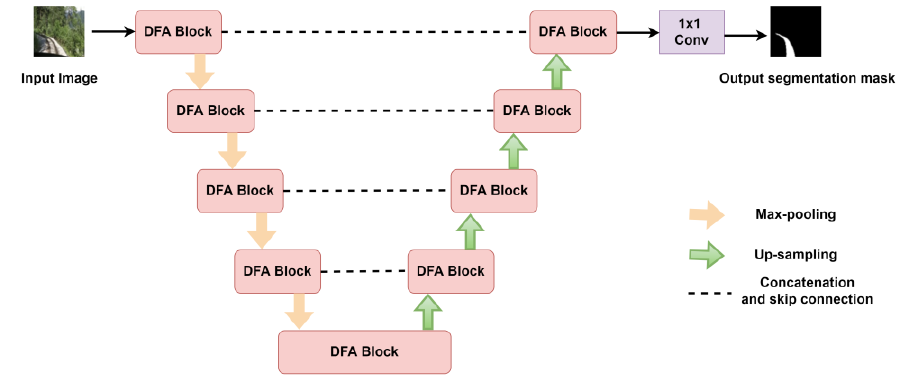
Figure 3. DFA-UN et network architecture designs. Figure 3. DFA-UNet network architecture